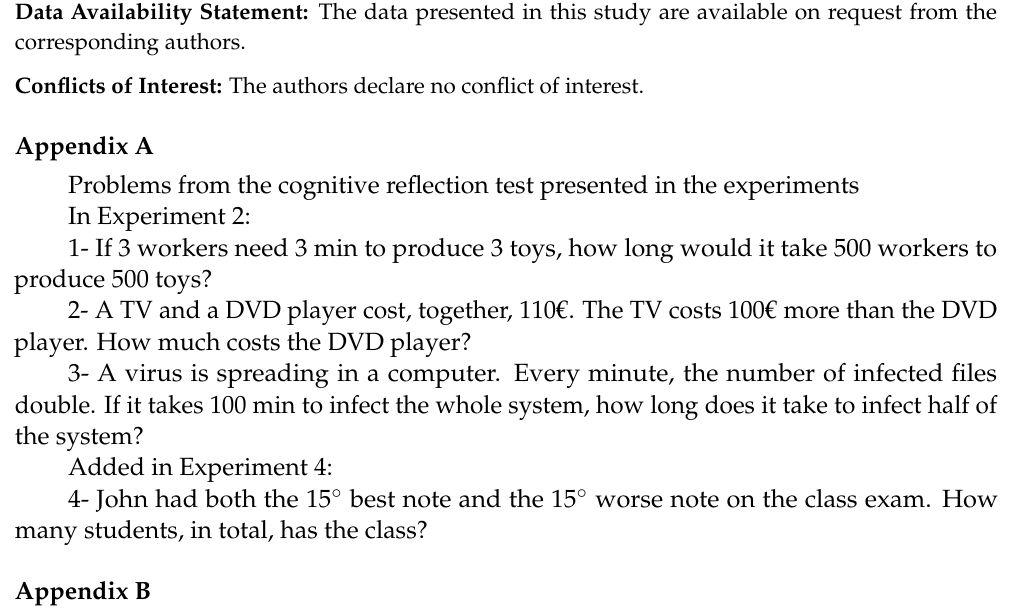
Table A1. Means and standard errors of base-rate responses for different problems in each experiment. Subsample Last Base Rates Last M (SE) M